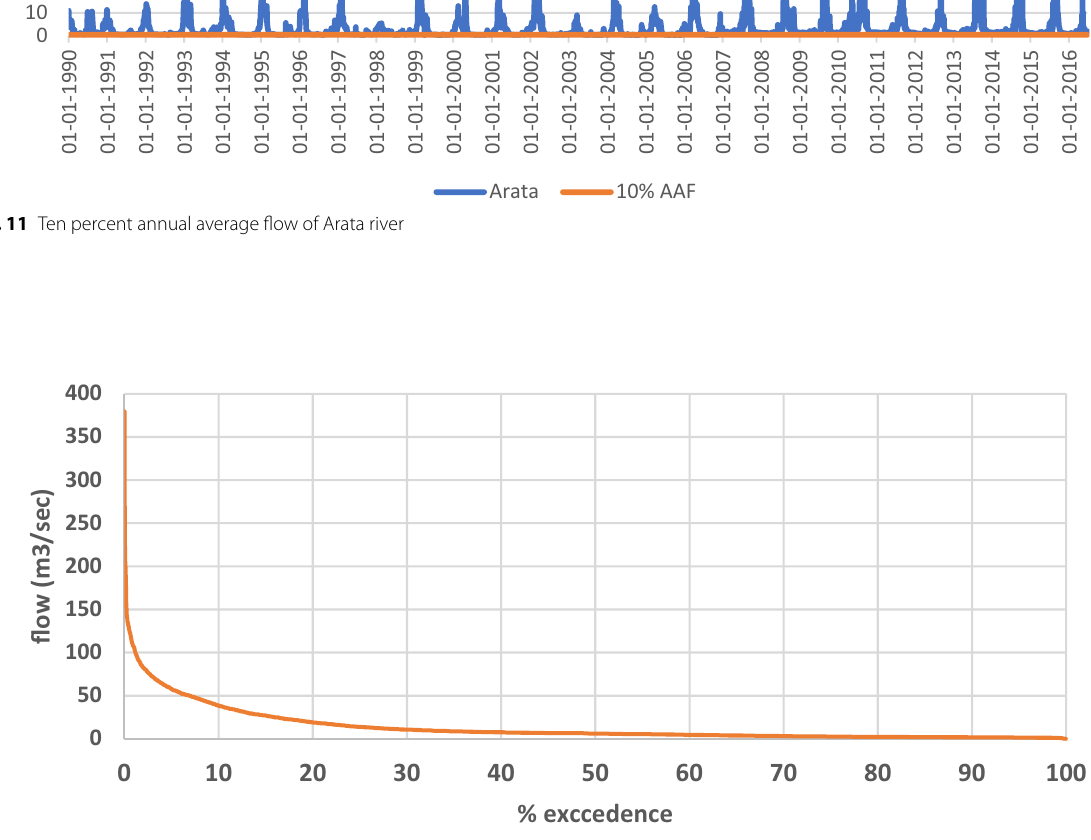
Fig. 12 Ketar river flow duration